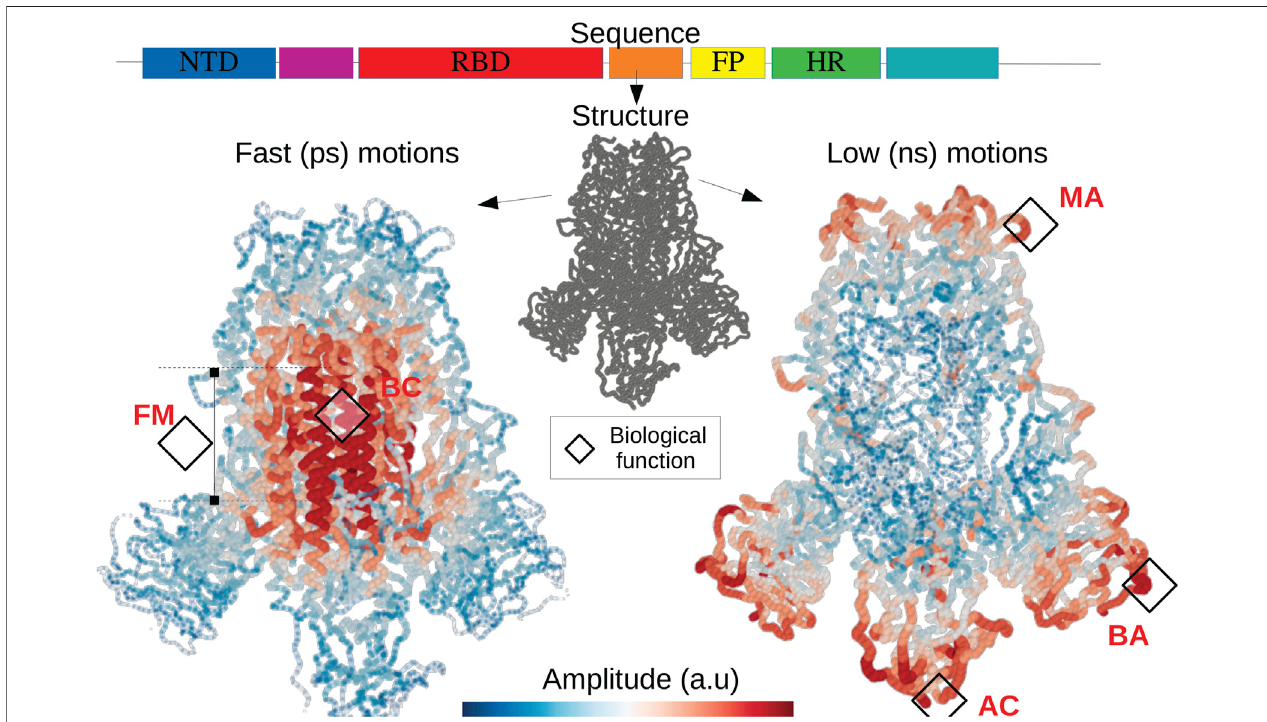
FIGURE 6 | The fold encoded functional dynamics of SARS-Cov2 Spike protein The translation of the RNA into a protein structure gives rise to two hidden landscapesoflocalizedmodescorrespondingtofastandshorttimescales.Thelocalizationlandscapesallowtopredictfunctionaldomainssuchasthefusionmachinery (FM) as well as the bond cleavage (BC) (Walls et al., 2020),the scanning (Turo ň ová et al., 2020) as well as the binding (AC) with the host cell surface (Huang et al., 2020), the binding with potential neutralizing antibodies (BA). Other soft domains, allow to facilitate motions interfering with antibody (MA) (Turo ň ová et al., 2020) and subjected to several mutations. This illustrates the quantitative relationship between the expression of the DNA code and the physical origin of functional domains.